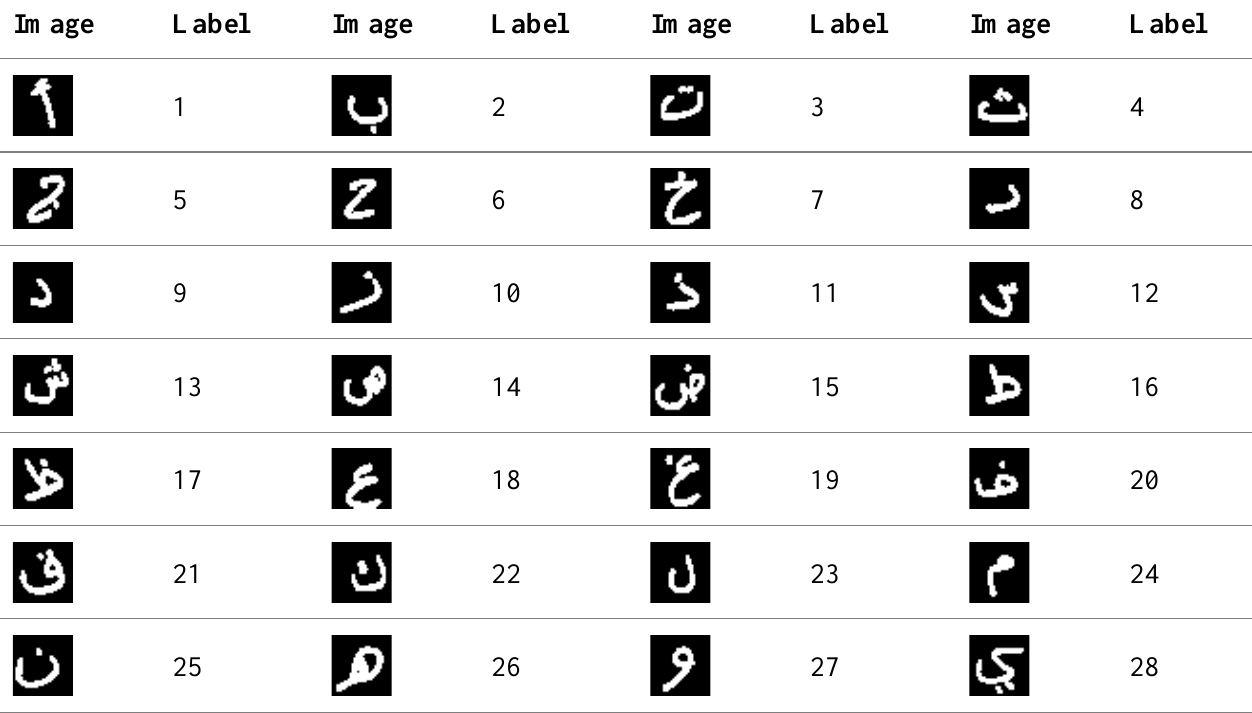
Table 1. letter image and its corresponding labels